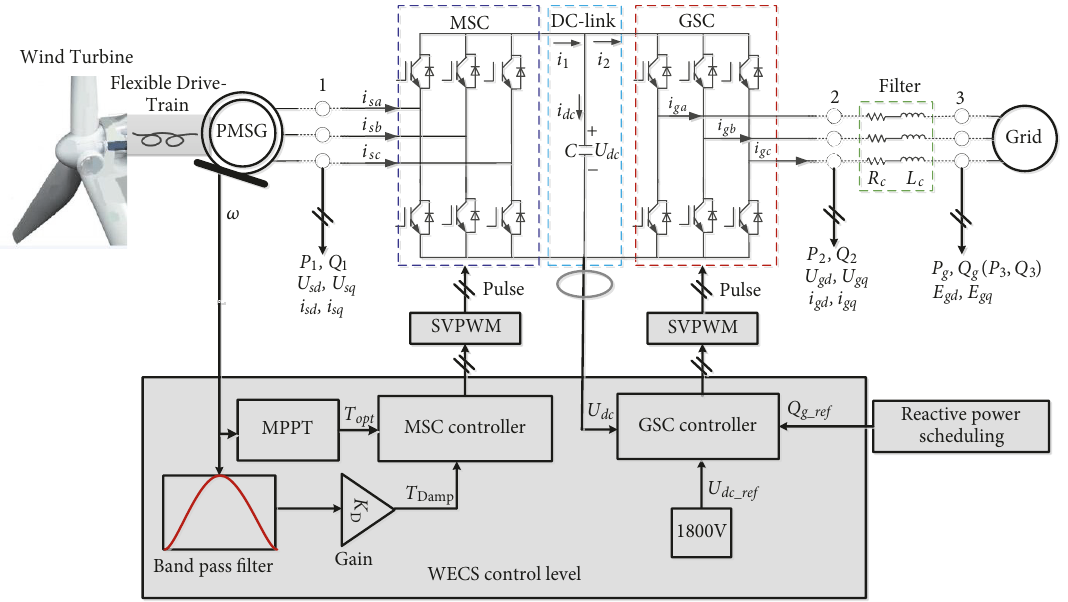
Figure 1: A WECS